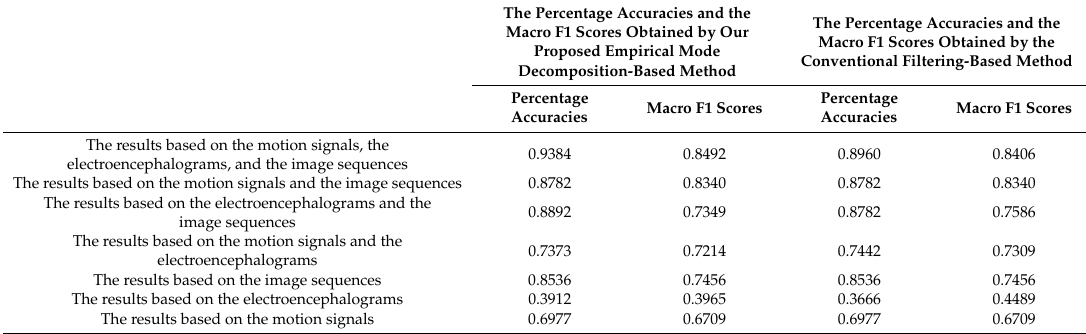
Table 4. The percentage accuracies and the macro F1 scores obtained by our proposed empirical mode decomposition-based method and the conventional filtering-based method using the signals acquired from the third